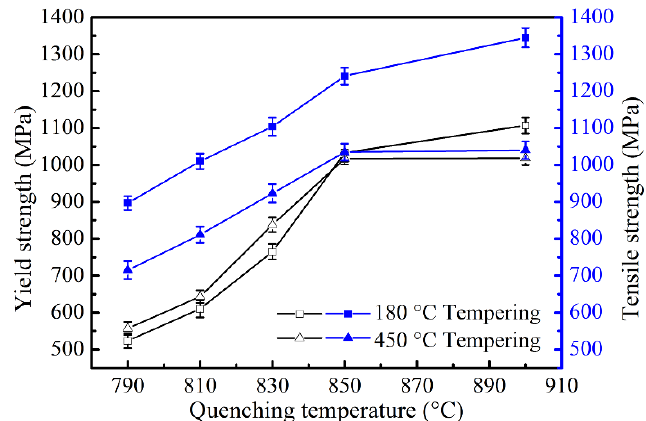
Figure 3. Yield strength and tensile strength as a function of quenching temperature tempered at 180 ◦ C and 450 ◦ C,